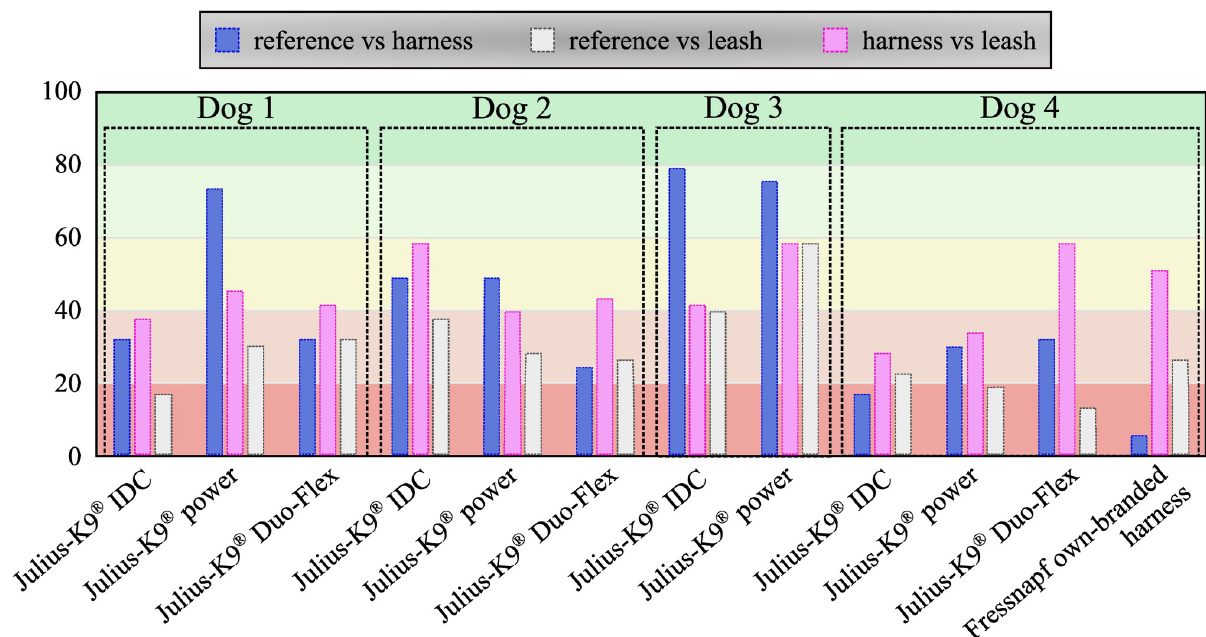
Fig 12. Result of Kolmogorov-Smirnov test for each trial grouped according to the different configurations. Percentage of parameters of a given case passed the two-sided Kolmogorov Smirnov test for identical distribution ( p > 0.05)(53 parameters in total).